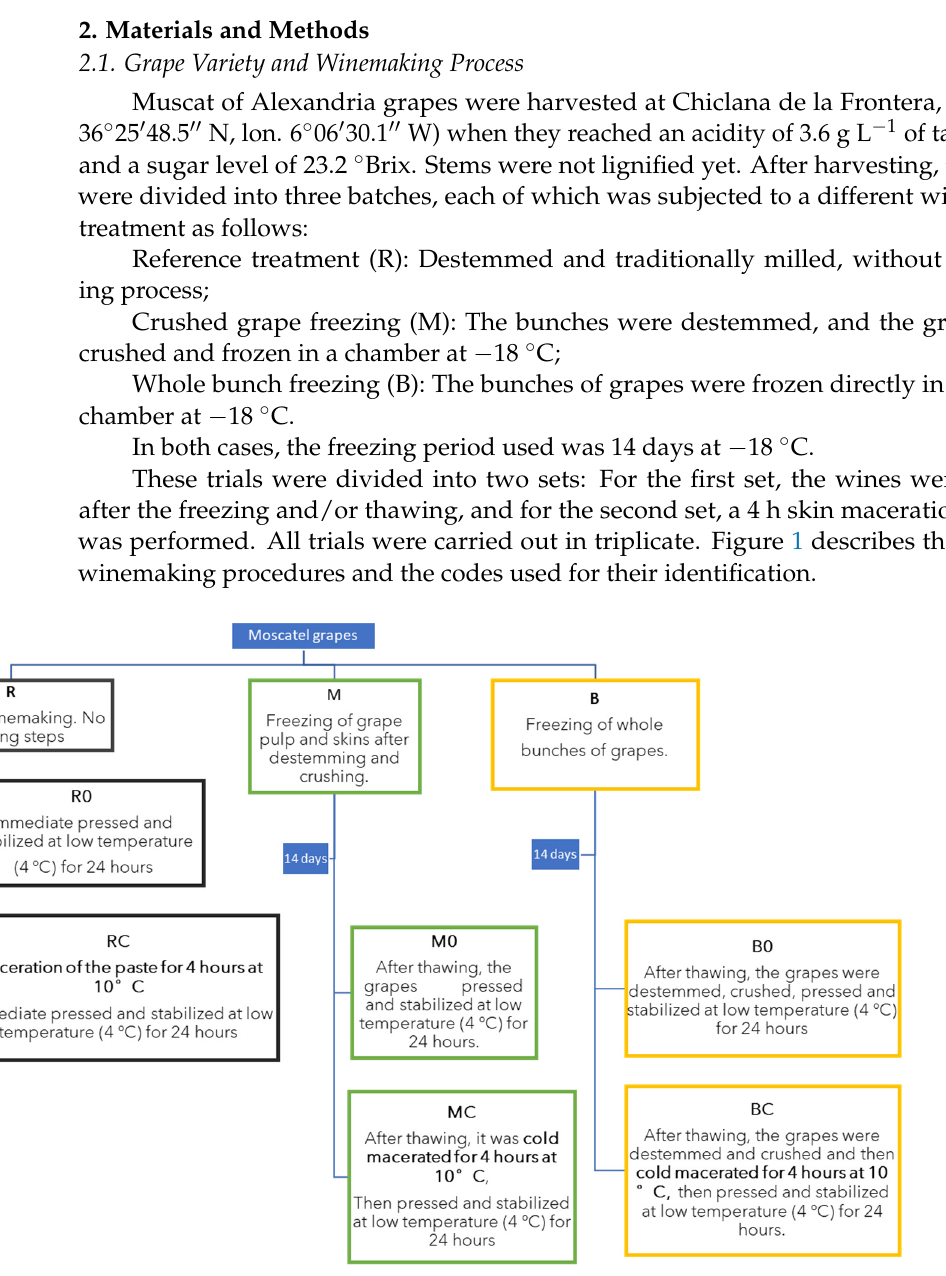
Figure 1. Description of the different winemaking procedures applied to the Muscat of Alexandria grapes. R0: regular winemaking; RC: regular winemaking with prefermentative maceration; M0: frozen crushed grapes then regular winemaking; MC: frozen crushed grapes and prefermentative maceration; B0: frozen bunches then regular winemaking; BC: frozen bunches and prefermentative